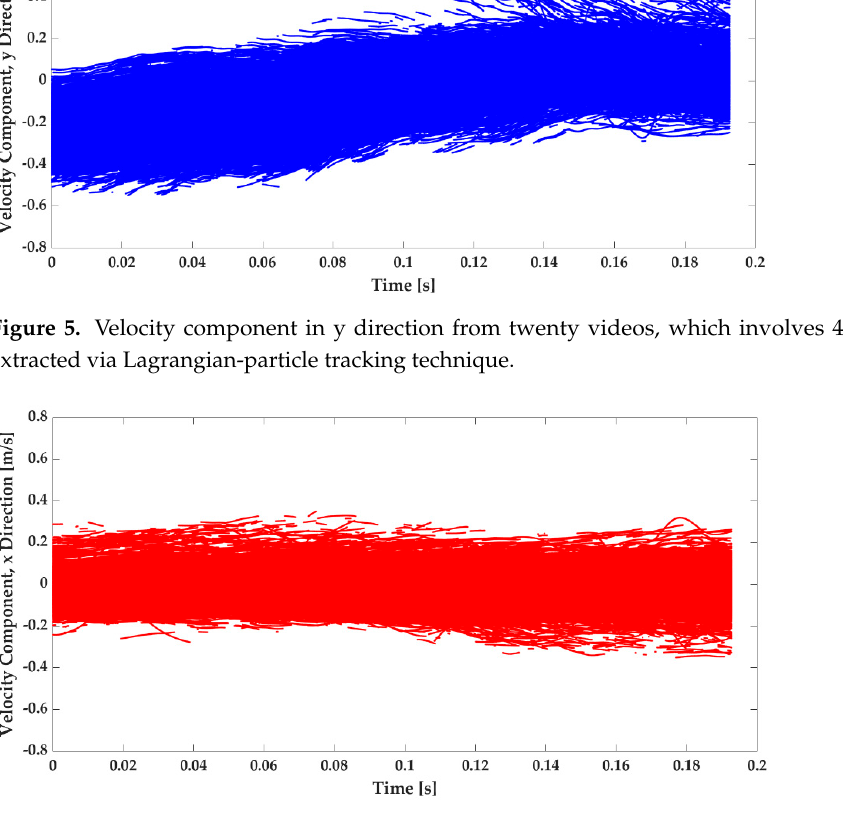
Figure 8. Prediction of velocity component in the y direction for a strained turbulent flow with mean strain rate 8 s − 1 , GRU model on the left ‐ hand side, and LSTM model on the right ‐ hand side. Training data are 60% and test data 40%. Figure 9. Prediction of velocity component in the x direction for a strained turbulent flow with mean strain rate 8 s − 1 , GRU model on the left ‐ hand side, and LSTM model on the right ‐ hand side. Training data are 80% and test data 20%.